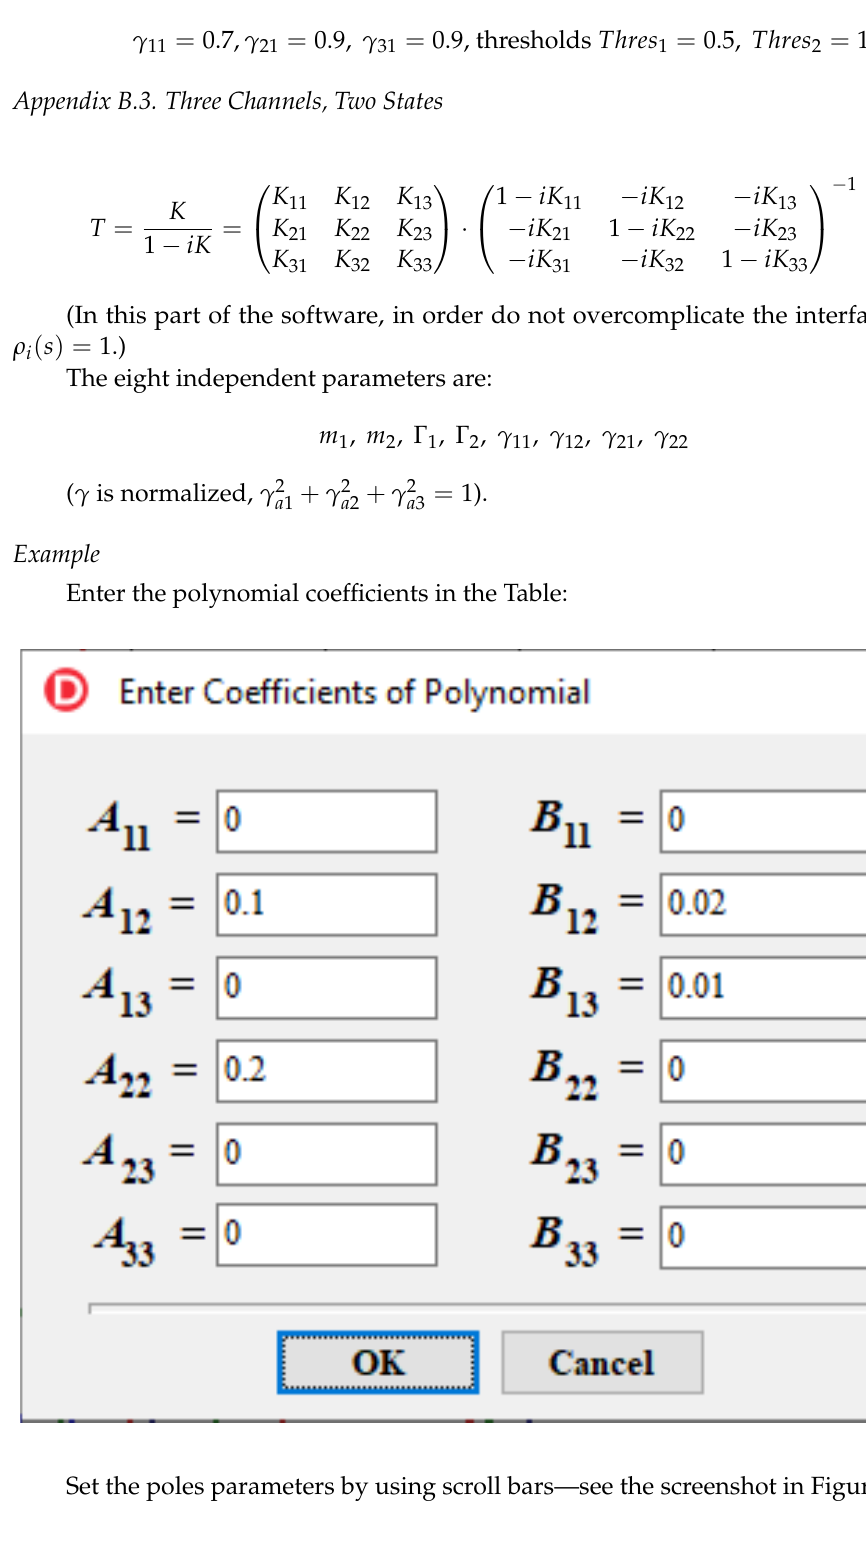
Set the poles parameters by using scroll bars- see the screenshot in Figure A3: